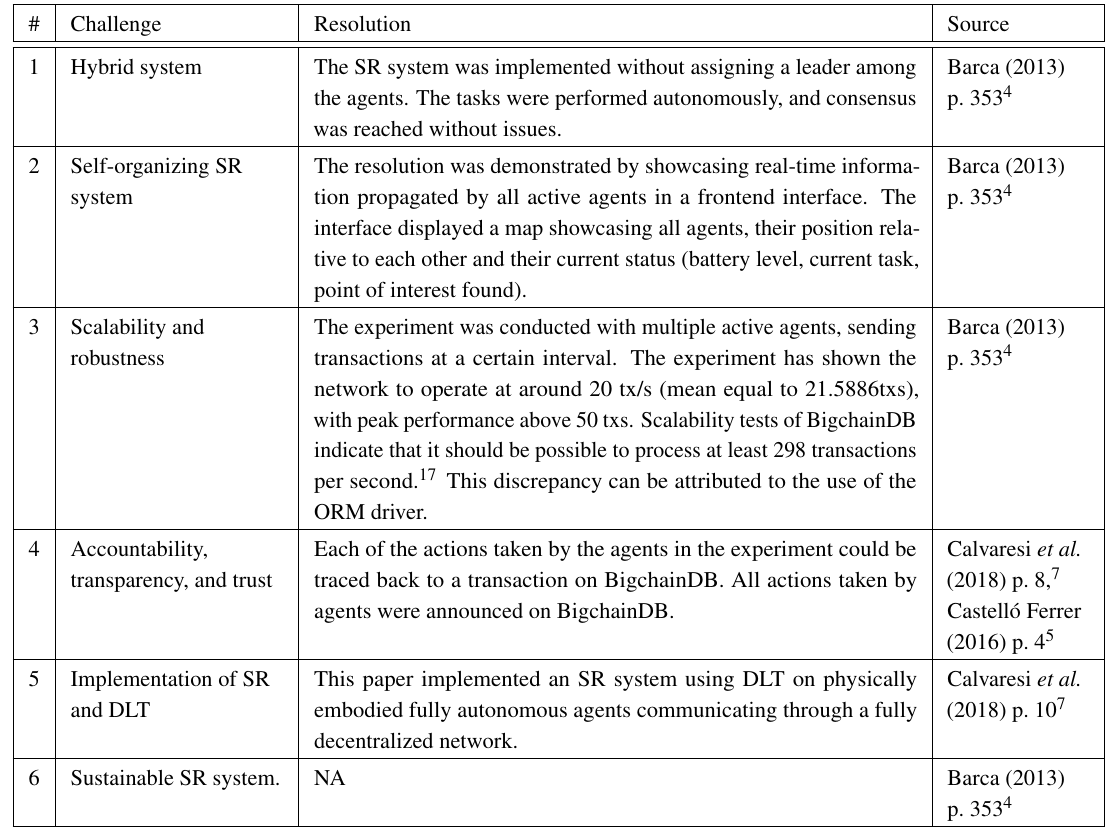
Table 2. A series of challenges that impede the widespread adoption of SR for real-world applications, and their resolution through DLT within this